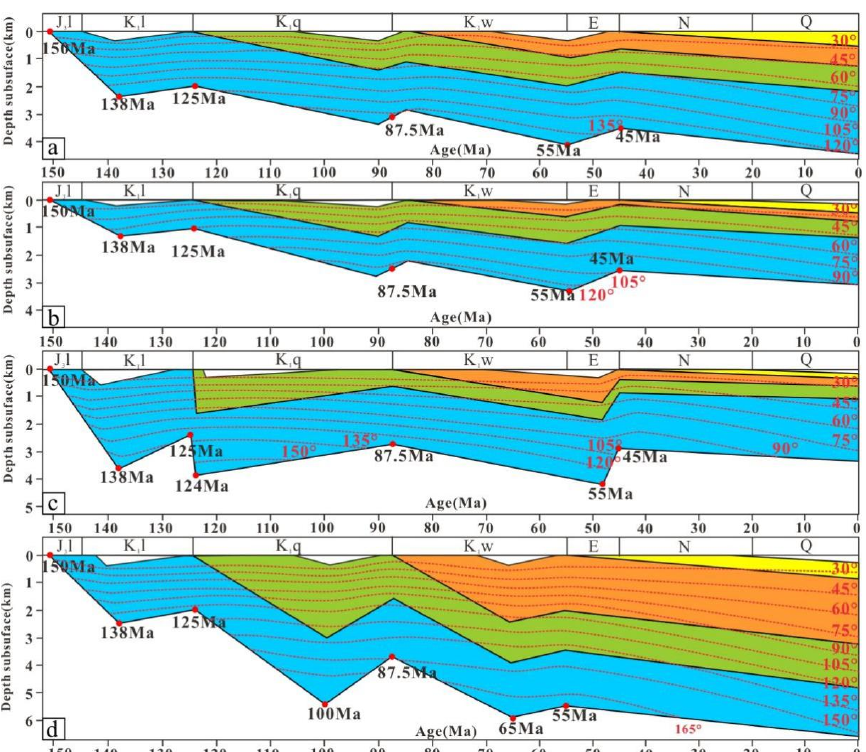
Figure 7. Implication diagram of burial history and geothermal history. ( a ) Zhucheng depression, western Jiaolai basin; ( b ) Laiyang depression, eastern Jiaolai basin; ( c ) Lingshandao–Laoshan depression, Ri-Qing-Wei basin; ( d ) Haiyang–Rushan depression, Ri-Qing-Wei basin. The western segment of the L1 seismic survey line is shown in Figure 1a.